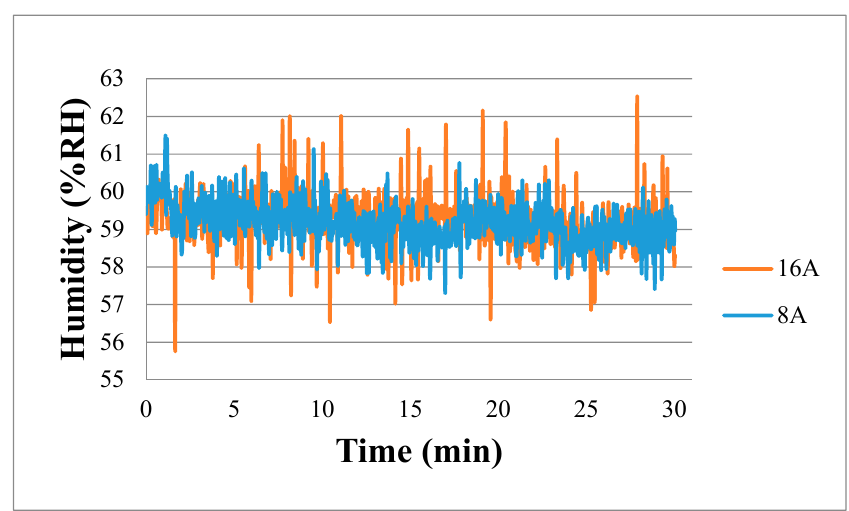
Figure 15. Real-time measurement of relative humidity.